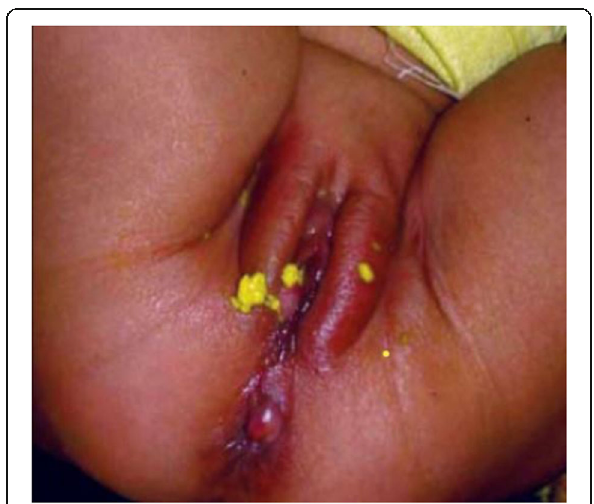
Fig. 3 Acquired fistula with perineal